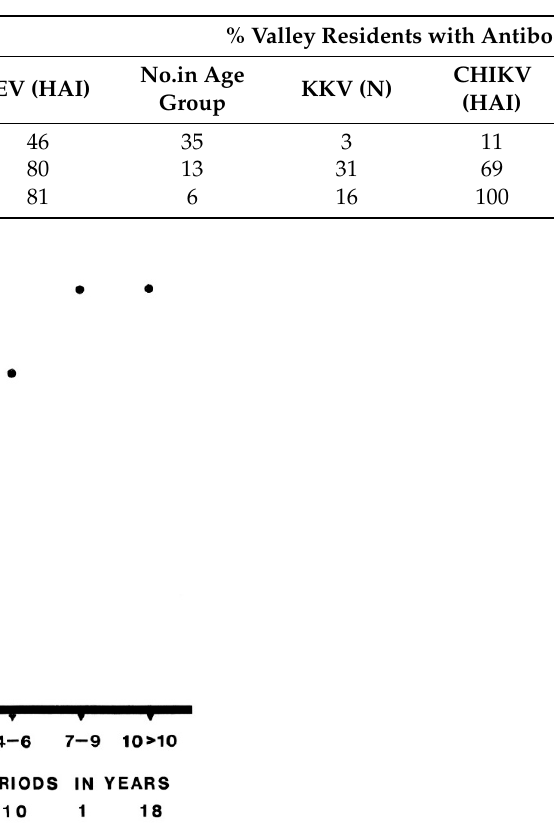
Table 2. Antibody prevalence to KKV, CHIKV, and JEV in guano miners and valley residents, by age. N = neutralization; HAI = hemagglutination inhibition.